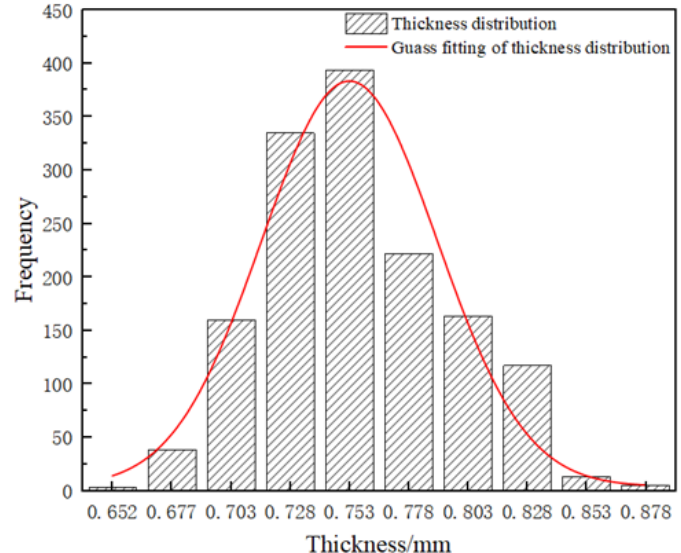
Figure 4. Distribution of thickness at all test points of all shells.